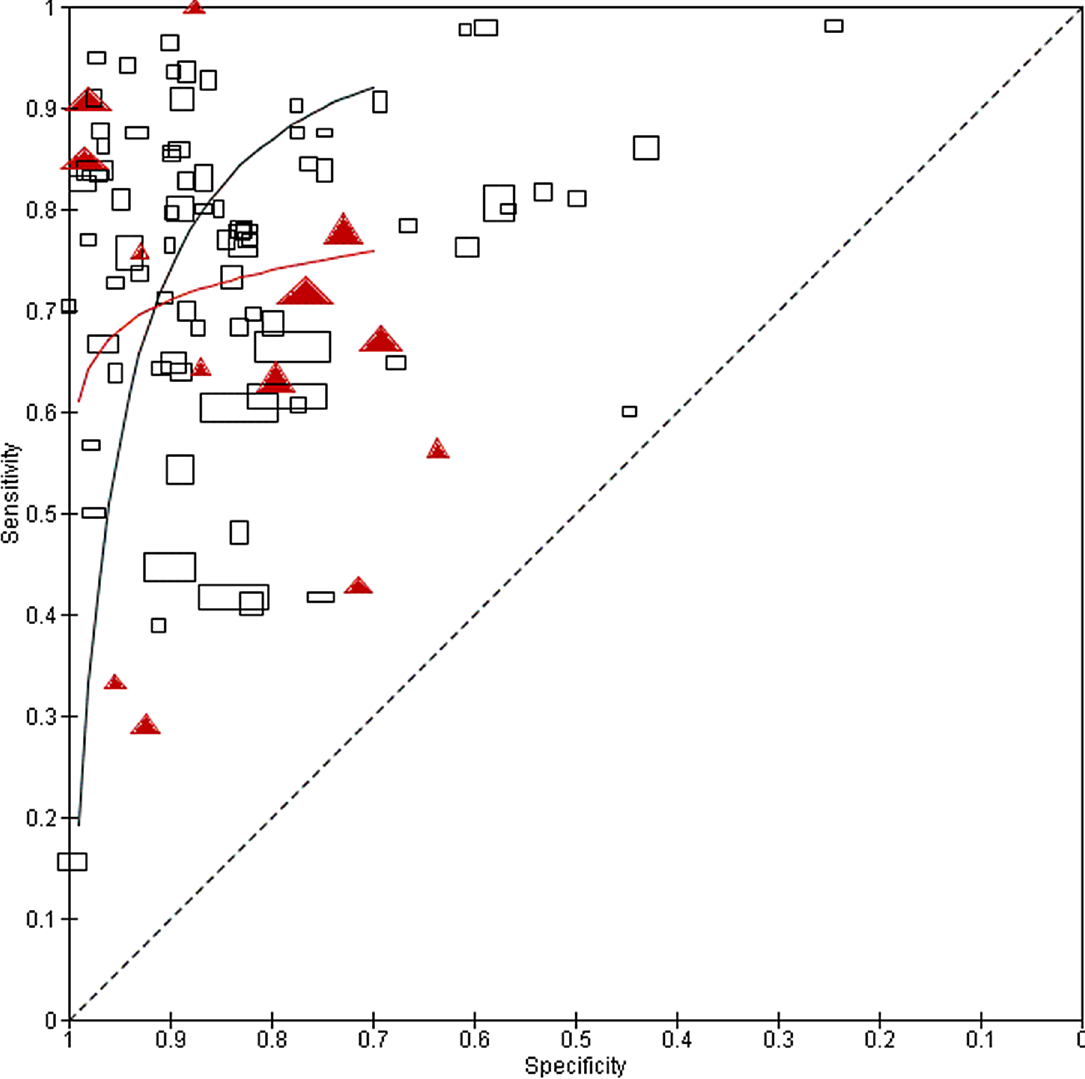
Figure 4. Performance of dipsticks for detection of S.haematobium egg-positive urine in pre- and post-treatment populations. ROC plot of sensitivity/specificity of dipstick performance among untreated populations, as compared to populations having had previous anti- schistosomal treatment. Untreated populations are indicated by open black rectangles, while previously treated populations are indicated by solid red triangles. Symbols for each study are proportional to study size. Curved lines indicate the summary performance curves estimated by HSROC for each group—for untreated populations in black (N=81) and for treated populations in red (N=13).